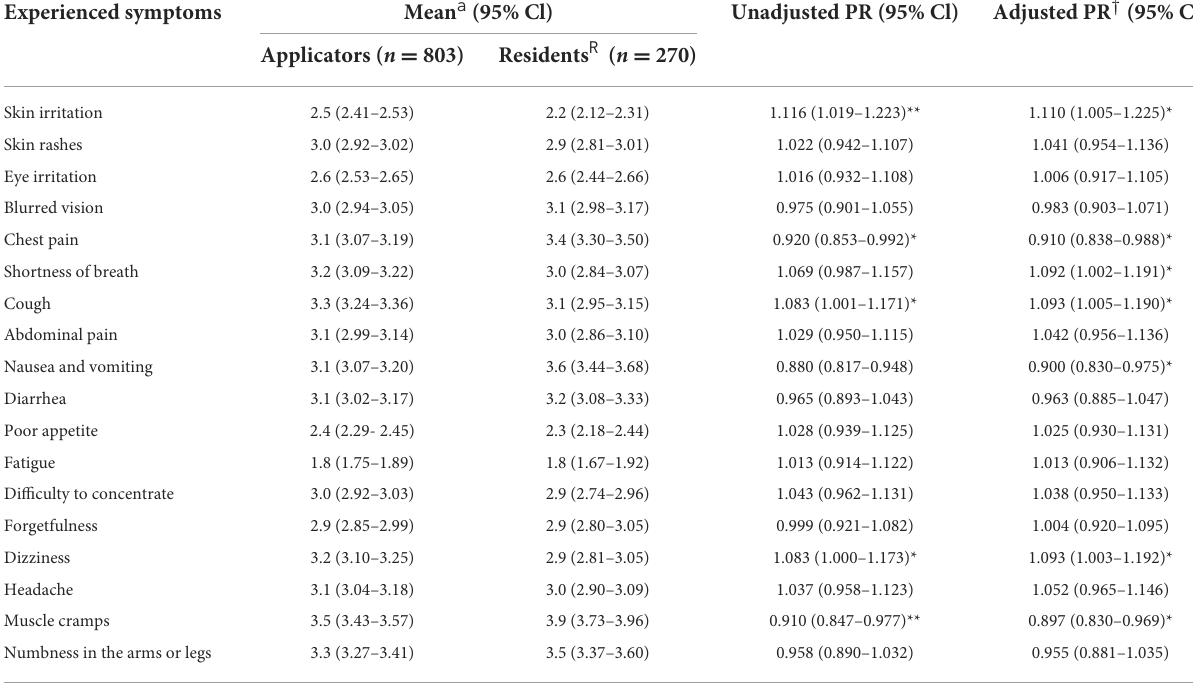
TABLE 7 Experienced symptoms among applicators and residents in East Hararge Zone, Oromiya Region,